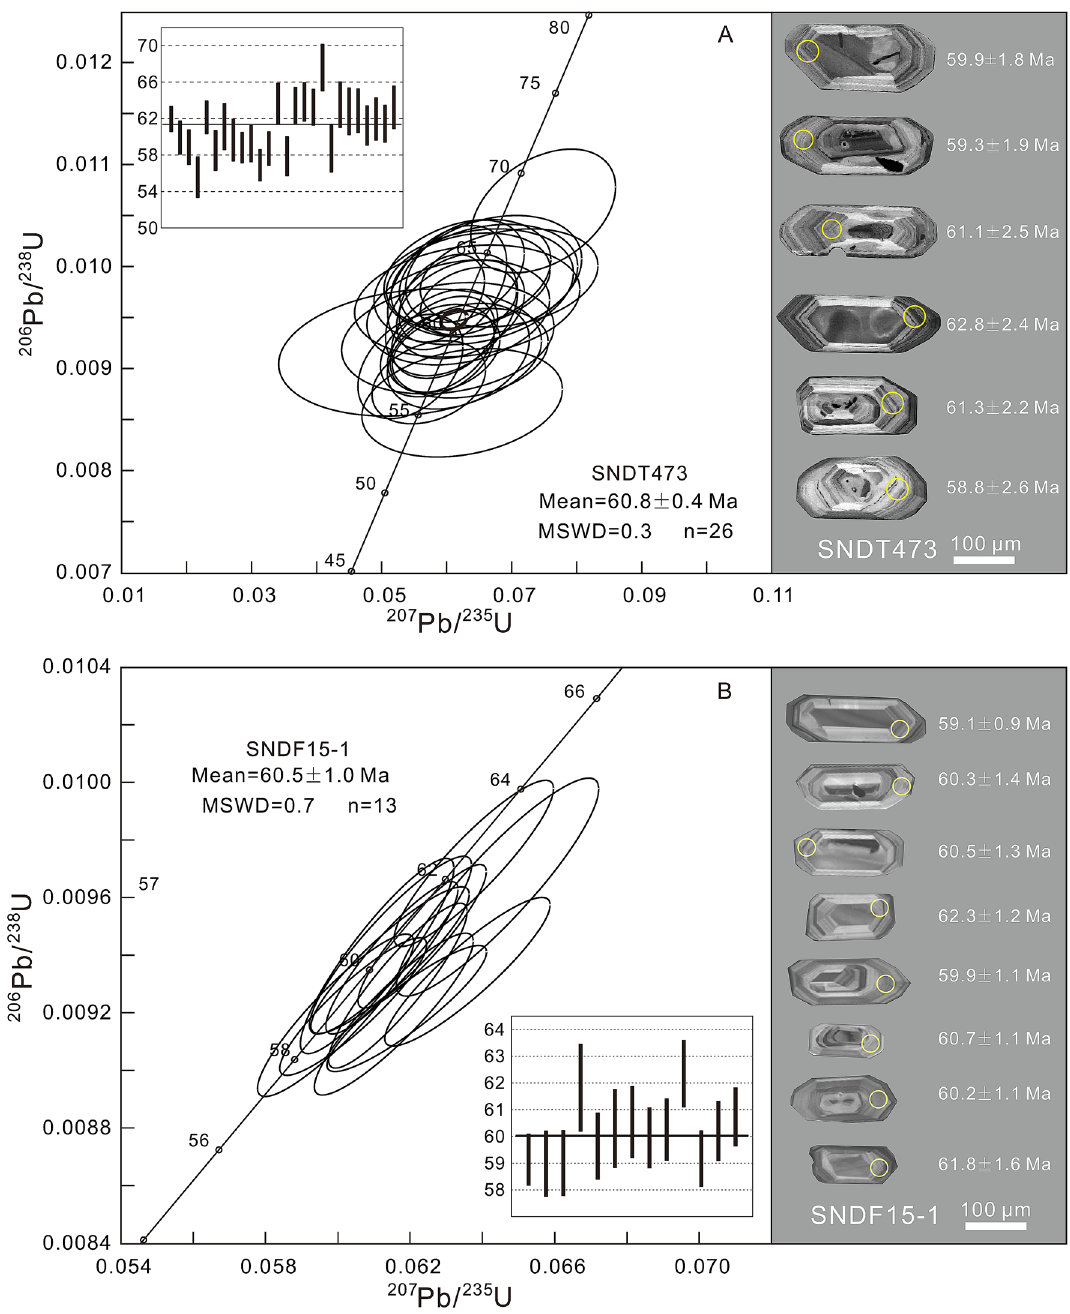
Figure 4. Zircon U–Pb concordia diagram and weighted ages for the Sinongduo Linzizong granitoids T473 ( A ) and F15-1 ( B ) showing typical cathodoluminescence (CL) images of representative zircons with 238 U/ 206 Pb